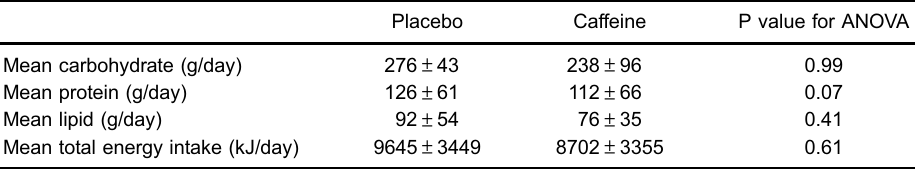
Data are reported as means ± SD of the average of all six training sessions. ANOVA detected no effect